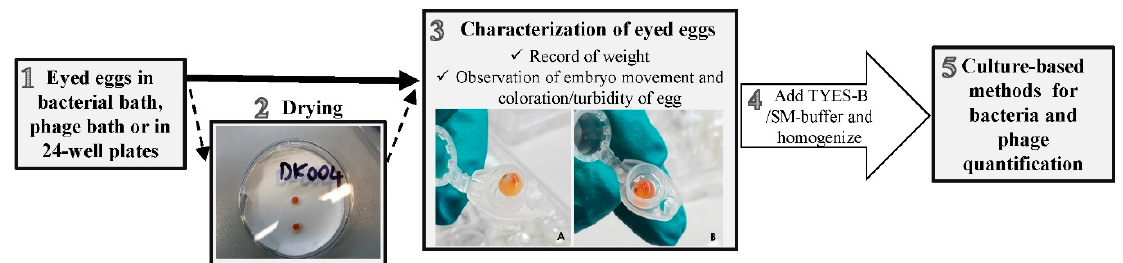
Figure 2. Graphical flow of the eyed eggs sampling procedure in relation to the experiments focused on F. psychrophilum and its phages. ( 1 ) Eyed eggs placed in the bacterial bath, the phage bath, or in 24-well plates were sampled at the selected time points. ( 2 ) A drying step was included for a selected number of eggs in Exp. I in section C. ( 3 ) Eyed eggs were characterized (A: example of turbid egg; B: example of normal coloration). ( 4 ) Sampled eggs were processed and homogenized. ( 5 ) According to the scope of the experiment, bacteria were enumerated and samples for phage analysis stored.